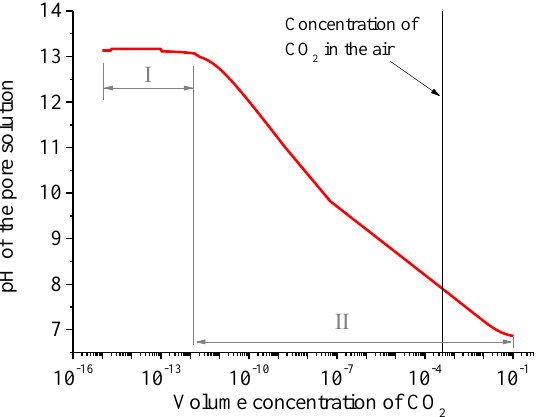
Figure 3. pH in the pore solution of the completely carbonated mortar as a function of the CO 2 concentrations. I and II in the figure represent the first and second stages, respectively.